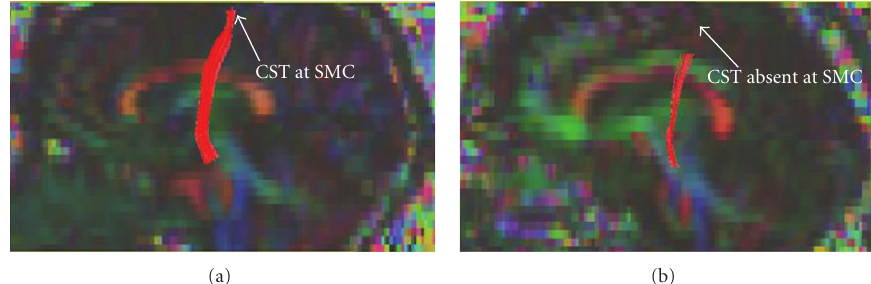
Figure 6: Sagittal views of FA color maps showing tractography-derived CST extending up to the submotor cortex (SMC) level in a control subject (a) but truncated in an UMN-predominant ALS patient with CST hyperintensity